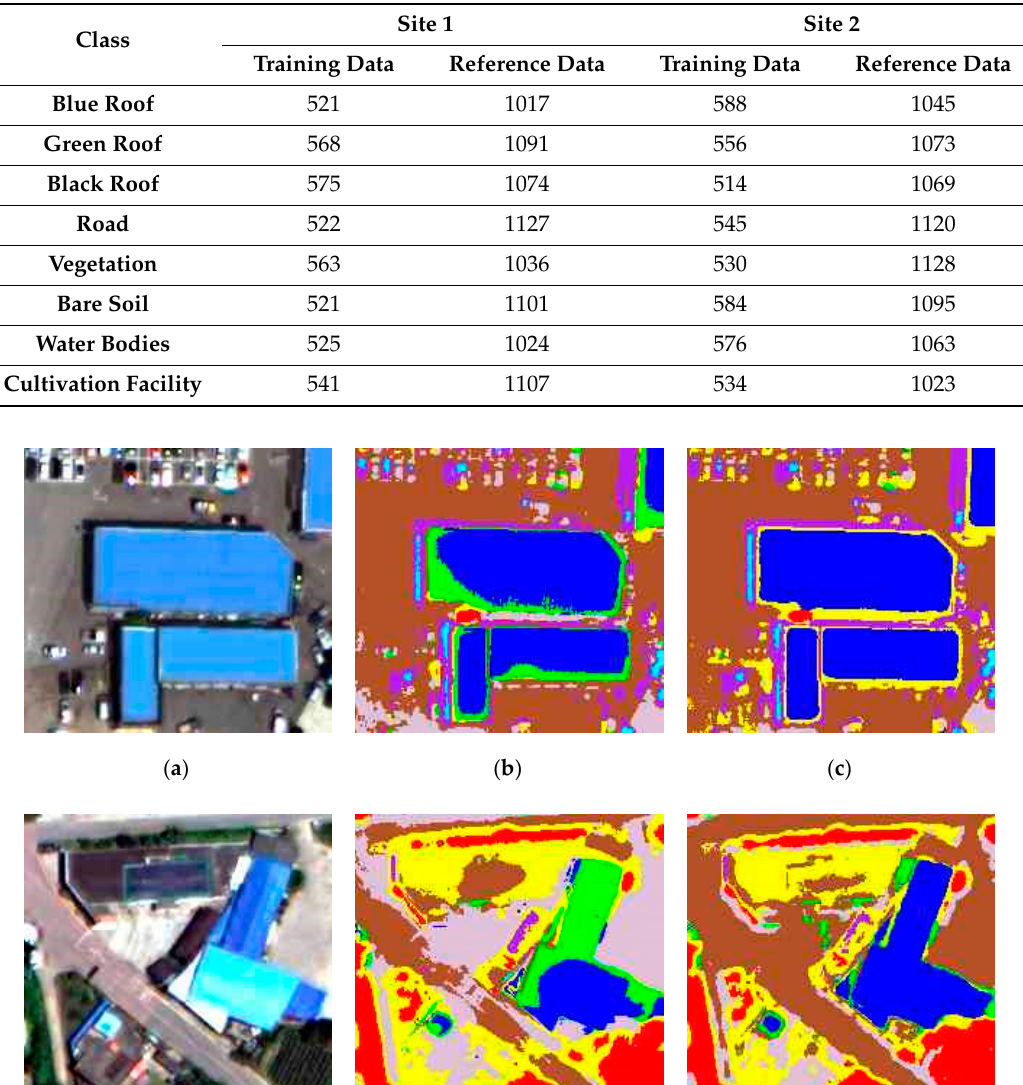
Table 4. Results of the quantitative accuracy evaluation.